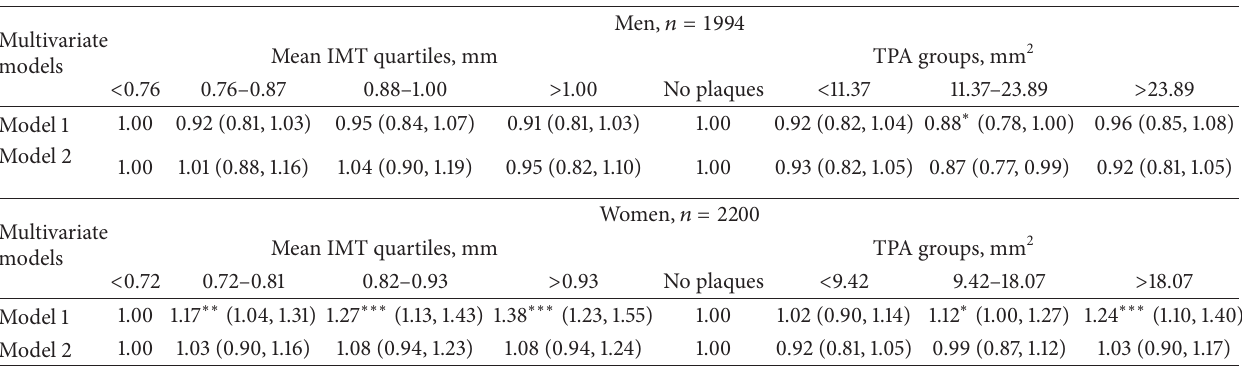
Model 1. Total calcium, unadjusted. Model 2. Total calcium adjusted for age, BMI, SBP, and total cholesterol. ∗ 𝑃 <